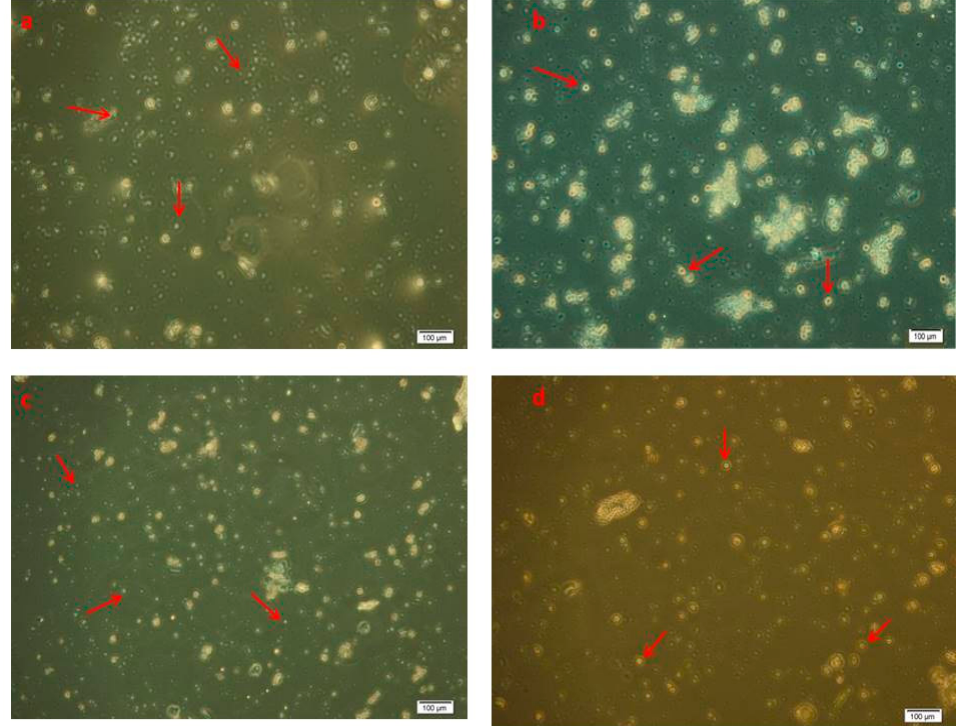
Figure 3. Microscopic images of the liposomes: ( a ) Liposomes with phosphatidylcholine (PC), ( b ) Liposomes with phosphatidylcholine with encapsulated Stellaria media (L.) Vill. extract (PCE), ( c ) Liposomes with phosphatidylserine (PS), ( d ) Liposomes with phosphatidylserine with encapsu- lated Stellaria media (L.) Vill. extract (PSE). The red arrows show the characteristic spherical shape of liposomes.